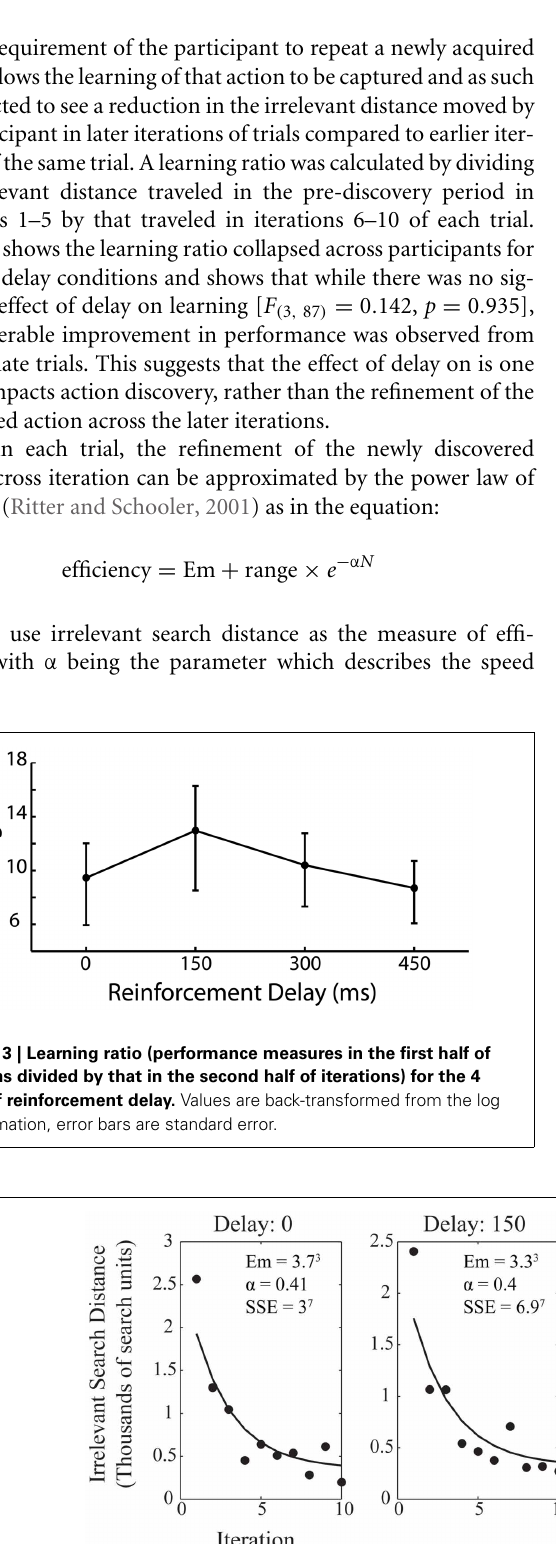
the fitting values for the power law, both for the fitted variables of the power law itself and the sum of squares due to error (SSE) goodness of fit value for the curve fitted to the